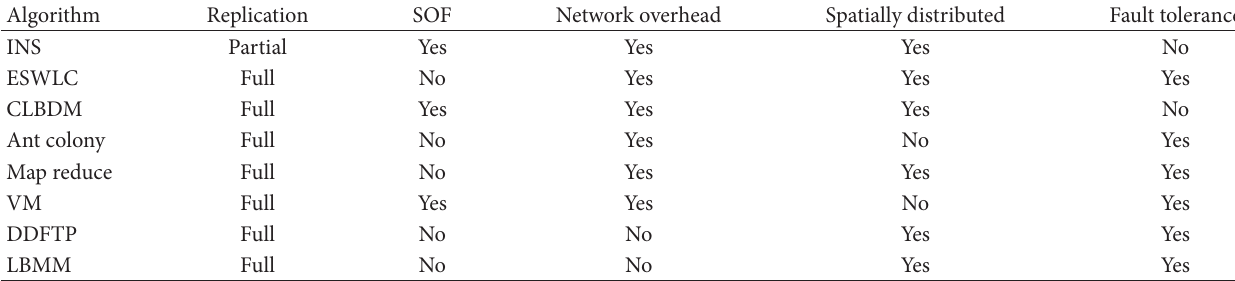
Table 2: Comparison of load balancing